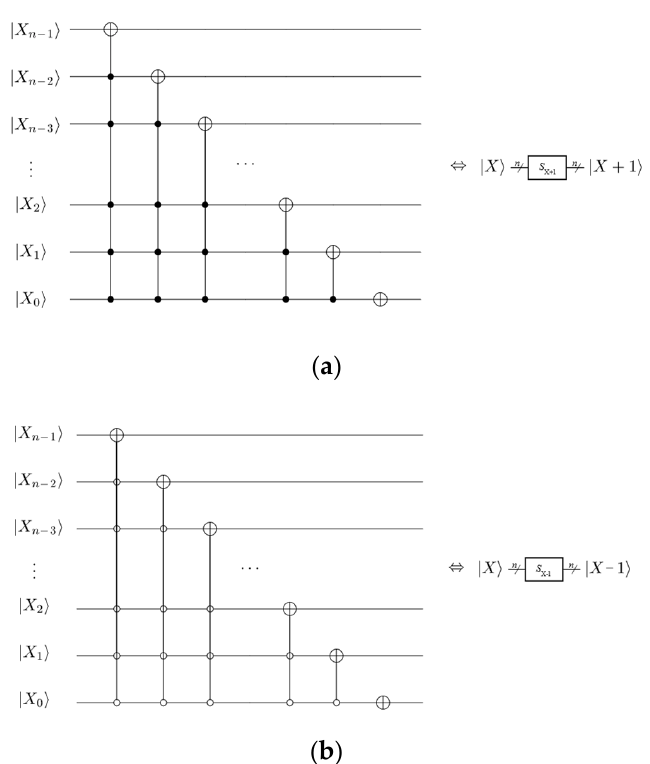
Figure 4. Address shift operation circuit. ( a ) Shift + operator circuit. ( b ) Shift − operator circuit.